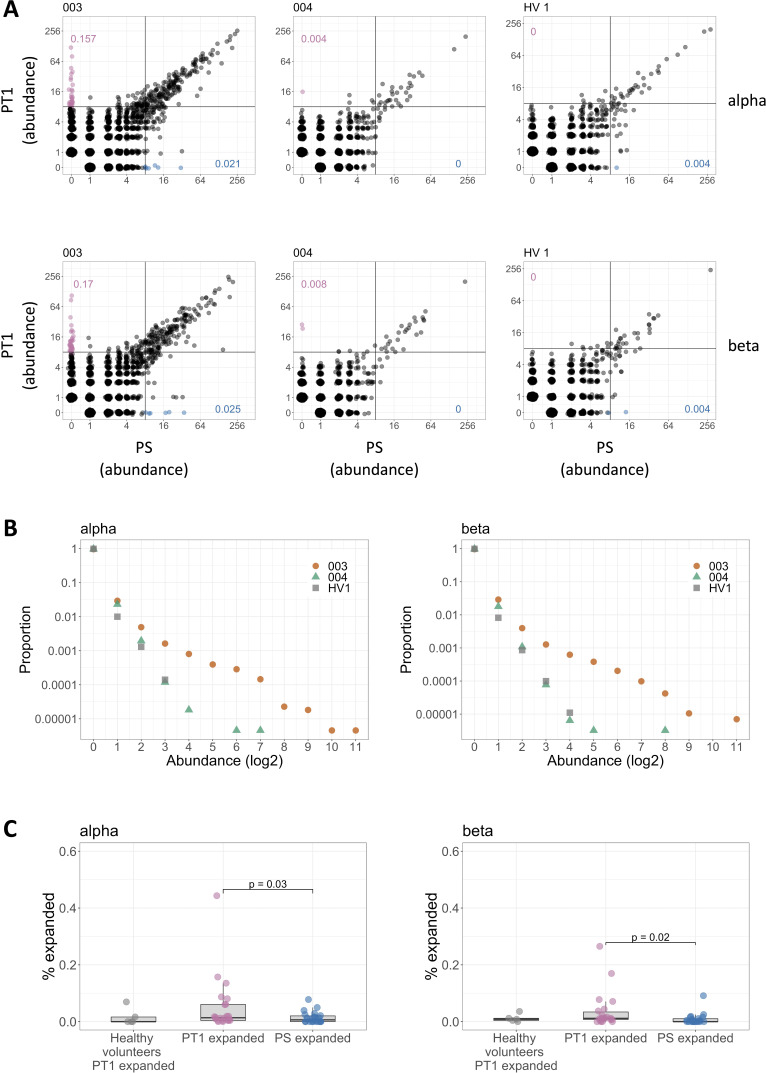
Sensitization with diphenylcyclopropenone (DPC) induces a transient expansion in the frequency of a small subset of the T cell receptor (TCR) repertoire.(A) The abundance distribution of TCRs at PS and PT1. All samples were subsampled to the same number of TCRs (28,000). Each unique TCR is represented by a dot, and the axes represent the number of times it is observed in the PS (x-axis) and PT1 (y-axis) sample of the same individual. The left and center panels represent two representative individuals. The right panels show one representative healthy volunteer at 0 and 2 weeks (equivalent timings to PS and PT1). The plots for all individuals are shown in Supplementary file 3. The pink dots identify a population of TCRs absent in the PS sample and expanded (abundance ≥8) in the PT1 sample. The blue dots identify a population of TCRs absent in the PT1 sample and expanded (≥8) in the PS sample. The numbers indicate the percentage of PT1 expanded TCRs (pink) and PS expanded TCRs (blue). (B) The abundance distribution profile of TCRs present at PT1 and absent at PS corresponding to the left panel in (A) (orange), middle panel (green), and right panel (gray). The y-axis shows the proportion of the TCRs which are found at the abundance indicated by the x-axis. (C) The distribution of the percentages of PT1 expanded (≥8) TCRs in healthy volunteers (n = 5) and in sensitized individuals (n = 22), and the distribution of the percentages of PS expanded (≥8) TCRs in sensitized individuals (n = 22), all subsampled as in (A). Bars show Wilcoxon signed–rank comparisons.